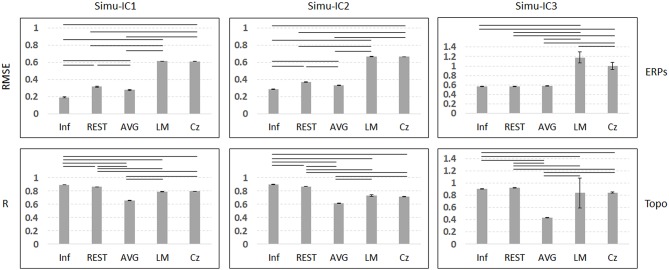
Results of one-way ANOVA (p < 0.001) and a post-hoc test (black line means p < 0.001) for simulation of SNR = 1. Vertical axis of the first row is the mean RMSE (with standard deviation) between true noiseless ERPs and ICA-extracted ERPs with a reference, while the vertical axis of the second row is the mean spatial correlation (with standard deviation) between true topographies and ICA-extracted topographies with a reference. Columns from left to right correspond to the ICA components (Simulation IC1–IC3).